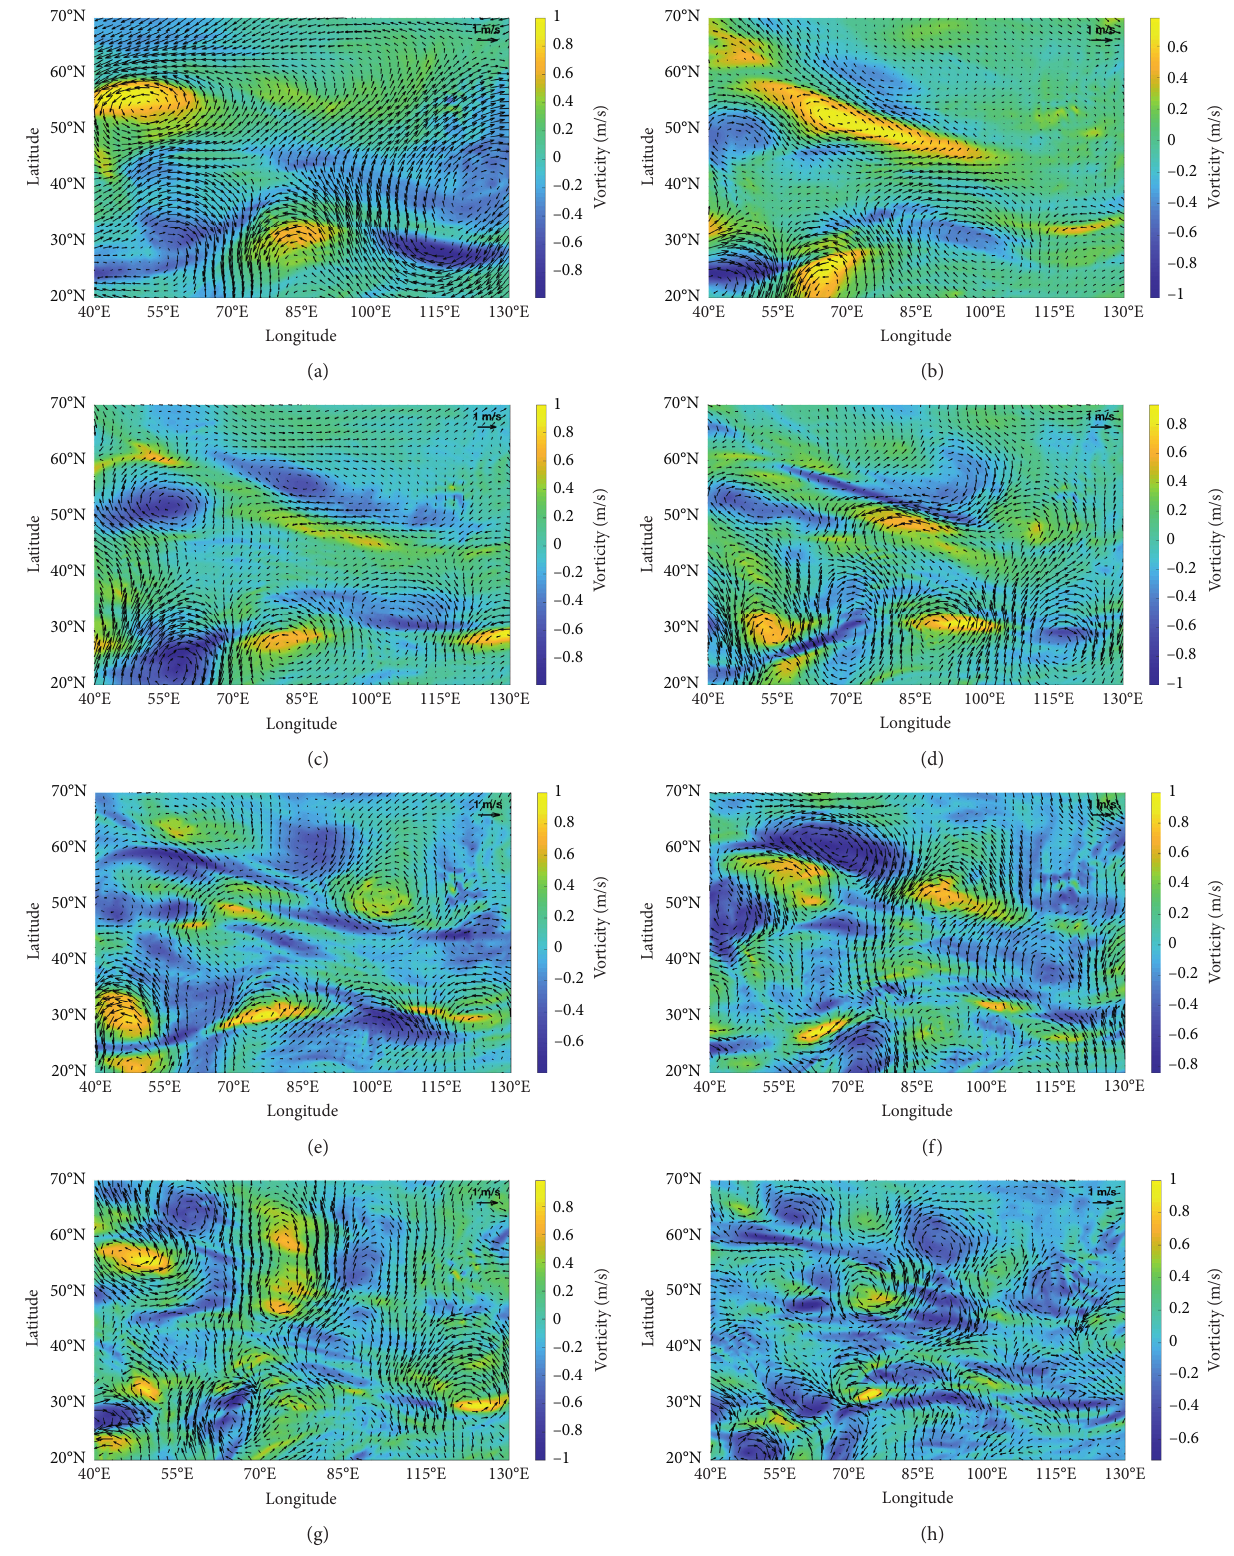
Figure 3: The first eight POD modes extracted from the 200hPa jet (a–h correspond to the 1–8th modes; wind velocity visualized by vector plots and the background color contours visualize the vertical vorticity